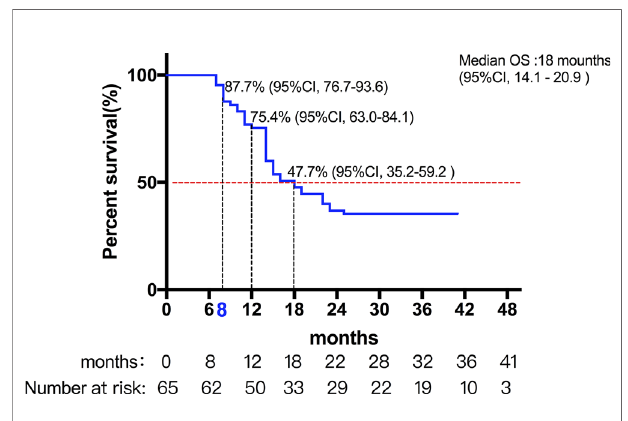
FIGURE 1 | The median OS of